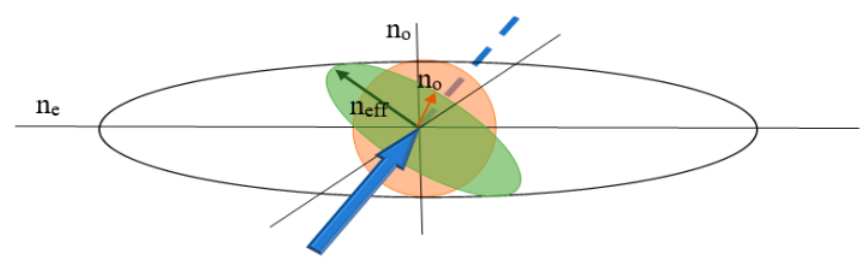
Figure 2. The scheme of an optic axis where birefringence is equal to ne-no and is a function of the